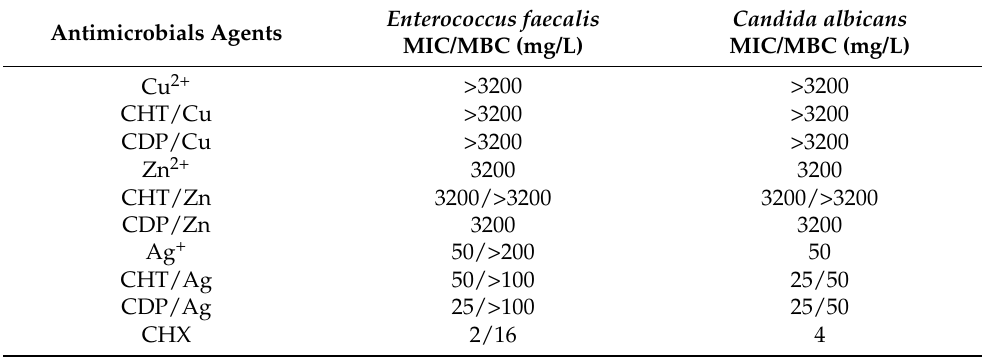
Table 1. Minimal inhibitory concentrations (MICs) and minimal bactericidal concentrations (MBCs) (mg/L) of copper (Cu 2+ ), zinc (Zn 2+ ), silver (Ag + ), and chlorhexidine (CHX) solutions, chitosan metal- lic nanoparticles (CHT/Cu, CHT/Zn, CHT/Ag), and cyclodextrin polymer metallic nanoparticles (CDP/Cu, CDP/Zn, CDP/Ag) against Enterococcus faecalis and Candida albicans ( n = 3). Enterococcus faecalis Candida Antimicrobials Agents MIC/MBC (mg/L)